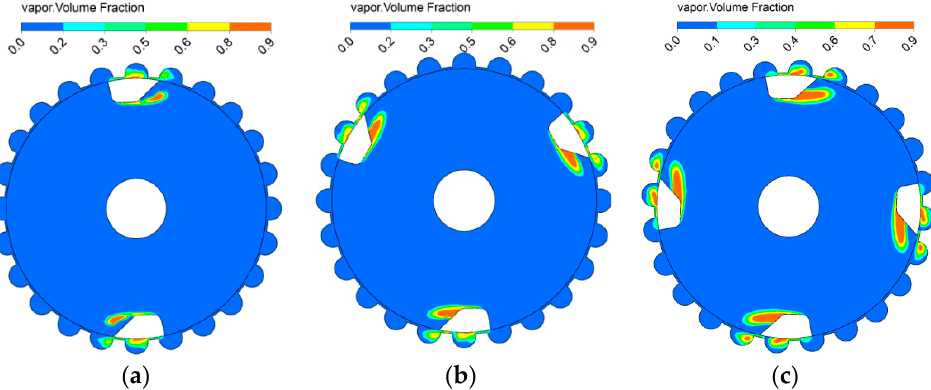
Figure 15. Vapor volume fraction of the cutter midsection with different numbers of cutter heads. ( a ) 2 cutter heads, ( b ) 3 cutter heads, ( c ) 4 cutter heads. ( a ) 2 cutter heads, ( b ) 3 cutter heads, ( c ) 4 cutter